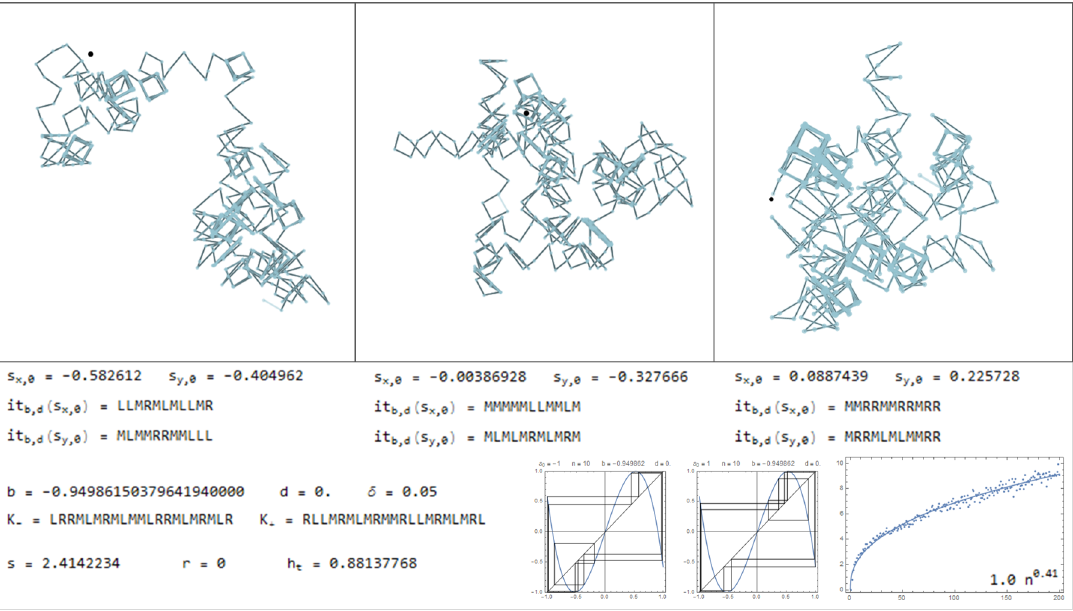
Figure 20. Trajectories produced with b = − 0.9498615 . . . and d = 0.